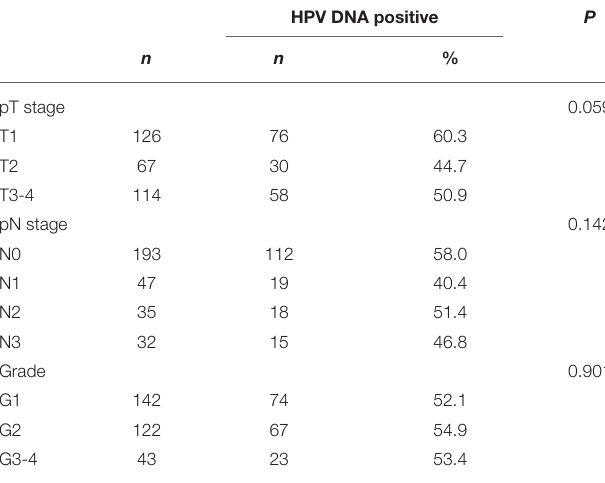
TABLE 4 | Tumor stage (TNM), tumor grade, and human papillomavirus DNA prevalence in invasive penile cancers. HPV DNA positive